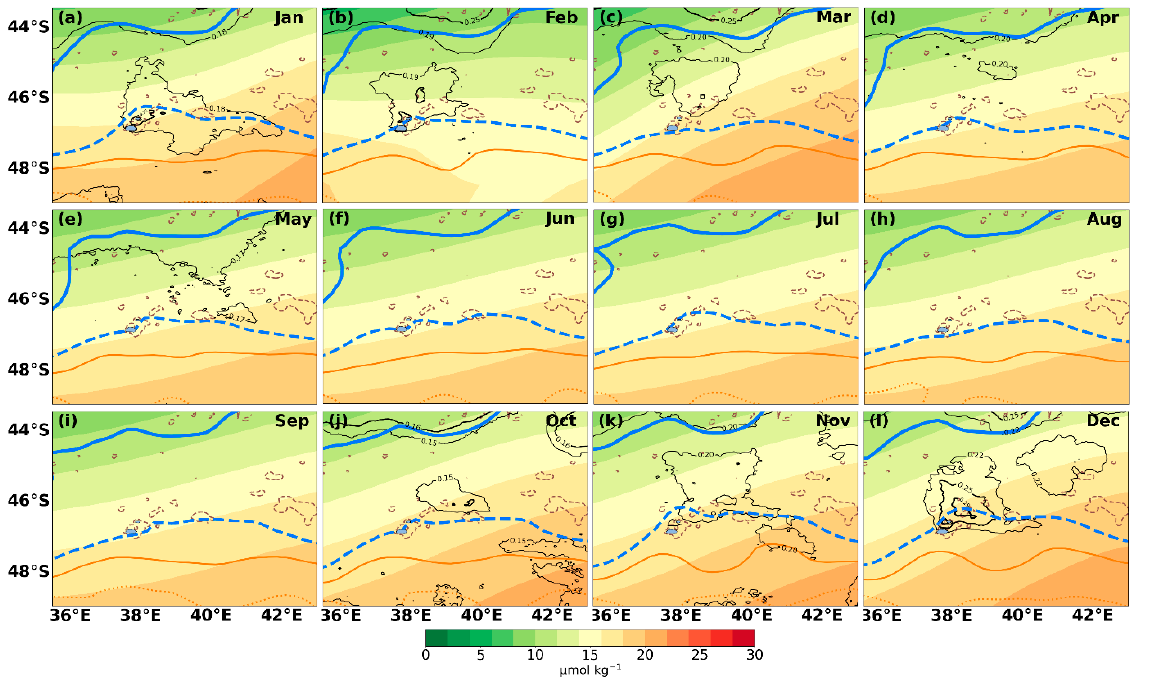
Figure 7. ( a – l ) Monthly (January to December) World Ocean Atlas 2018 climatology of nitrate (µmol kg − 1 ). The black contours indicate the lowest and highest chla (mg m − 3 ) concentrations that formed unique closed contours in our region of interest (0.18 and 0.25 in January; 0.19 and 0.25 in February; 0.20 and 0.25 in March; 0.20 in April; 0.17 in May; 0.15 and 0.16 in October; 0.20 and 0.25 in November; 0.22, 0.25, and 0.29 in December). The dashed brown contours indicate the 1000 m isobath. The solid and dashed thick blue lines show the climatological mean positions of the middle (M-SAF) and southern (S-SAF) branches of the sub-Antarctic Front, respectively. The solid and dotted thick orange lines illustrate the climatological mean positions of the northern (N-APF) and middle (M-APF) branches of the Antarctic Polar Front, respectively.